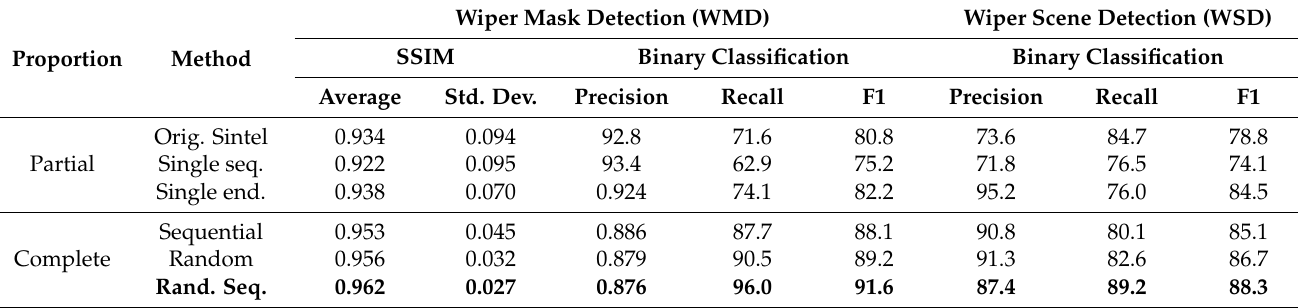
Table 4. Results of raft-things fine-tuned with various data synthesis